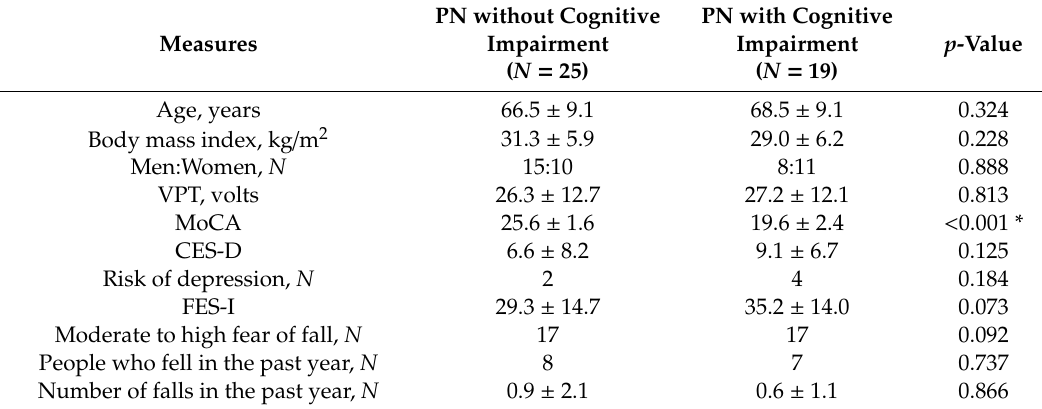
Table 1. Participant characteristics for each group. PN—peripheral neuropathy; VPT—vibration perception threshold; MoCA—Montreal Cognitive Assessment; CES-D—Center for Epidemiological Studies Depression Scale; FES-I—Falls E ffi cacy Scale